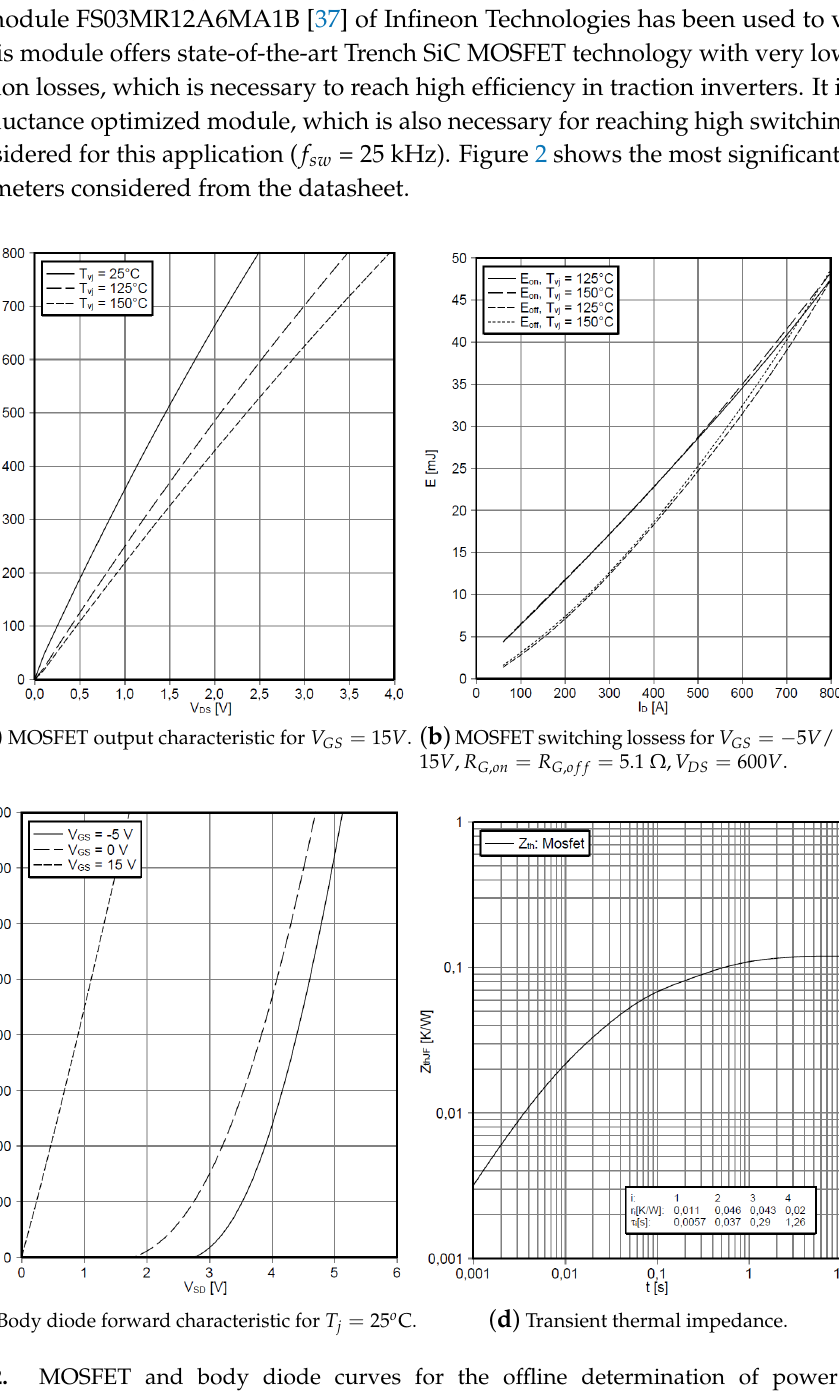
Figure 2. MOSFET and body diode curves for the offline determination of power losses of the FS03MR12A6MA1B Silicon Carbide (SiC) power module. Source: “Target Datasheet of FS03MR12A6MA1B: Version 1.1”